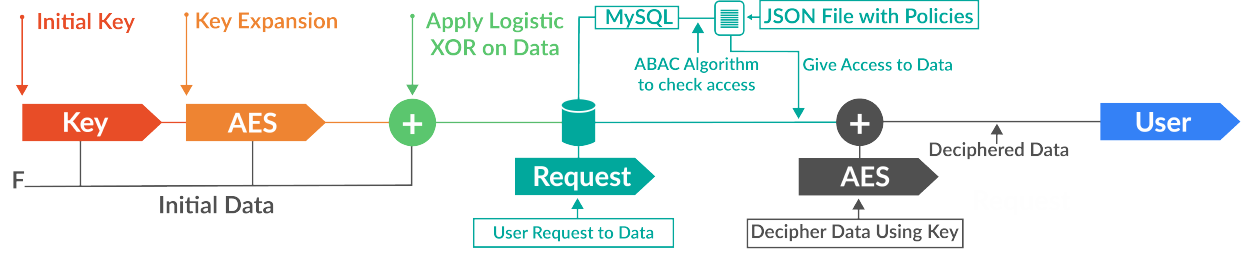
Figure 2. Data encryption and data access